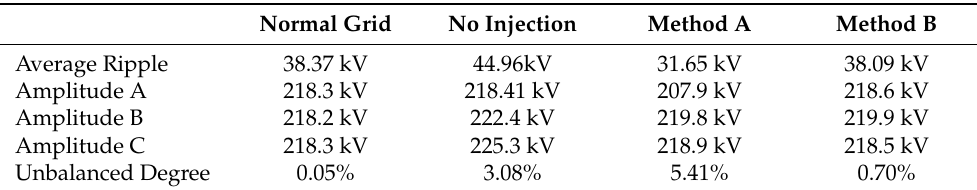
Table 2. Submodule-capacitor voltage ripple values of the proposed methods. Normal Grid No Injection Method A Method